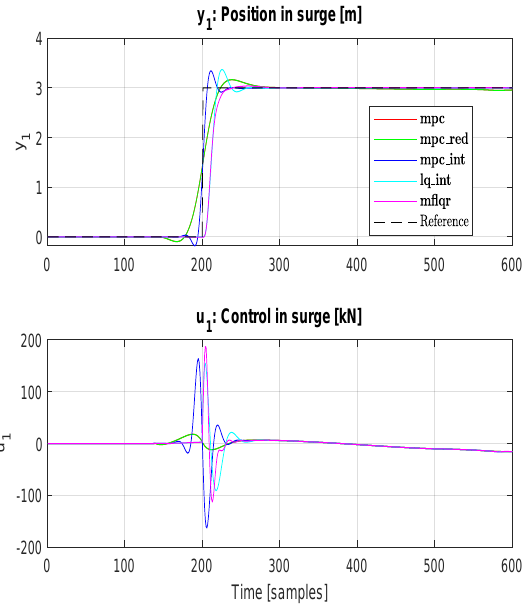
Figure 4: The figure shows the reference/setpoint step in surge position for the five different DP sys- tems controller algorithms.